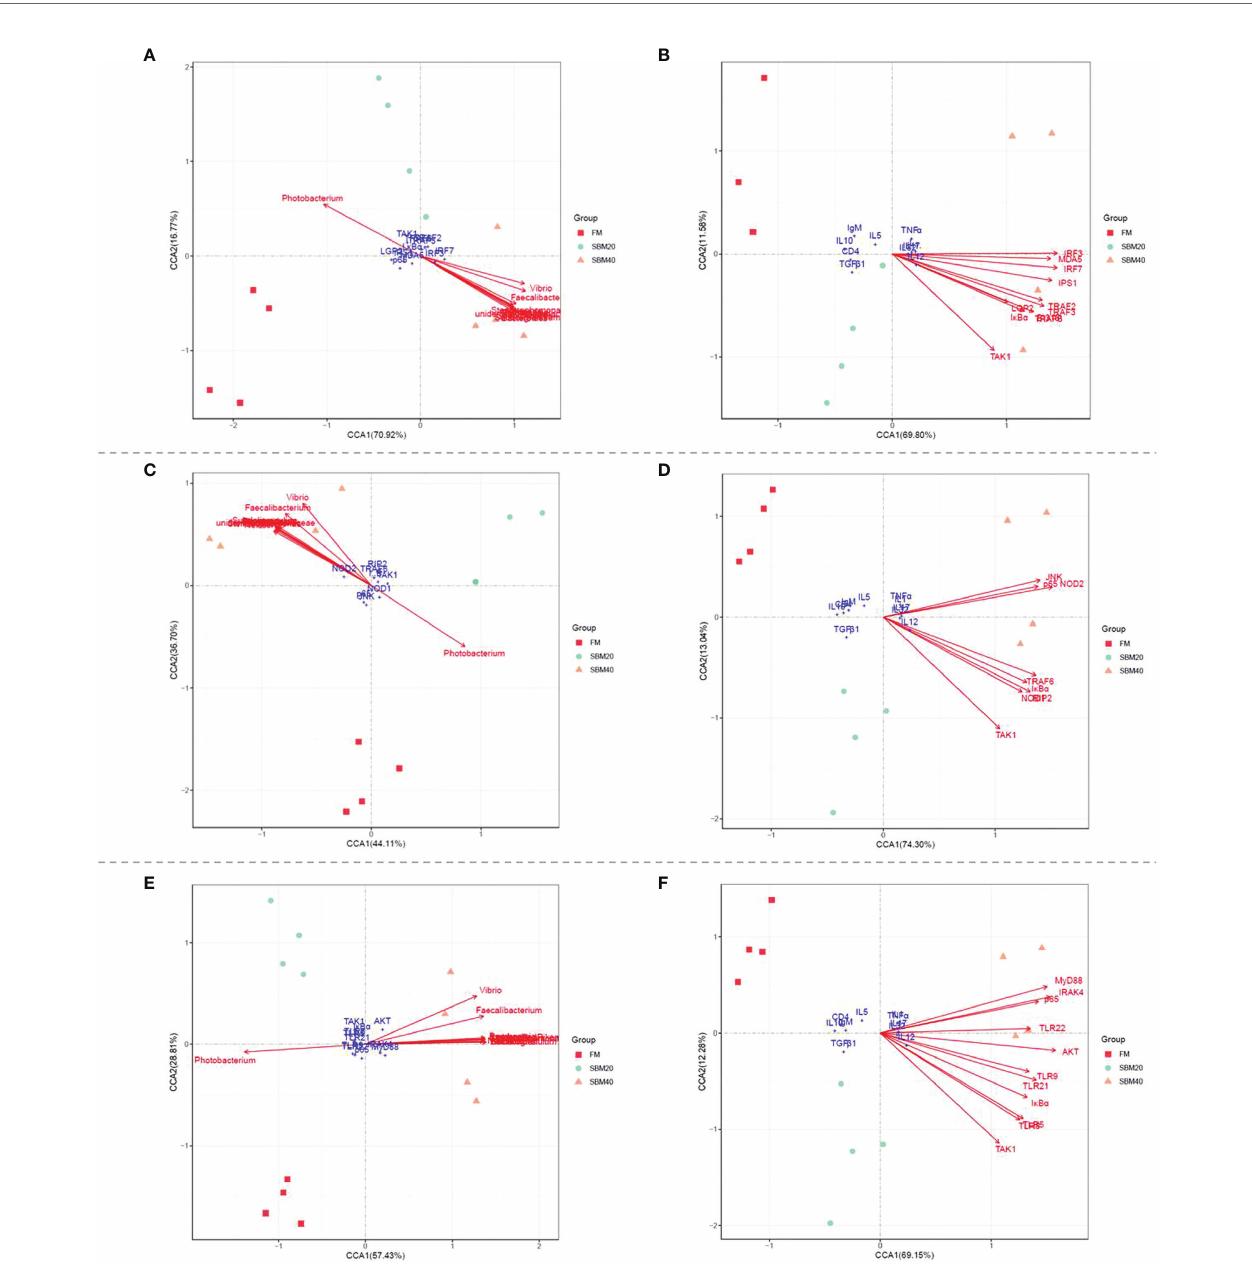
FIGURE 9 | The canonical correlation analysis (CCA) between the OUT abundances of intestinal fl ora, the key genes in PRR signaling pathways, and the in fl ammatory genes ( n = 4). (A, C, E) The CCA correlation analysis between intestinal fl ora and the key genes in RLR, NLR, and TLR signaling pathways, respectively. (B, D, F) The CCA correlation analysis between the key genes in RLR, NLR, and TLR signaling pathways and in fl ammatory genes, respectively. In CCA plot, the arrows represent explanatory variables and the points represent response variables. The lengths of the arrows represent the strength of the in fl uence of the explanatory variable on the response variable; the longer lengths indicate greater in fl uences. The angles between the arrows and coordinate axis represent the correlation between the explanatory variable and coordinate axis; smaller angles indicate stronger correlation. A sample point located in the same direction as the arrow indicates that the changes in explanatory and response variables are positively correlated, while in the opposite direction which indicates a negative correlation. The value in the coordinate axis label in the plot represents the interpretation proportion of the explanatory variable combination and the response variable